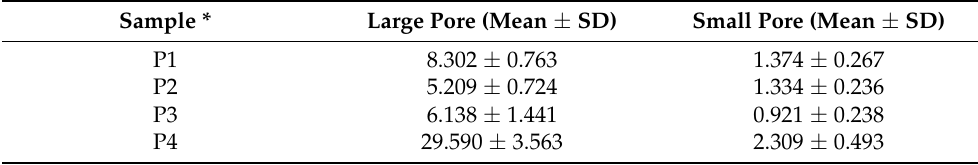
Table 1. Pore size